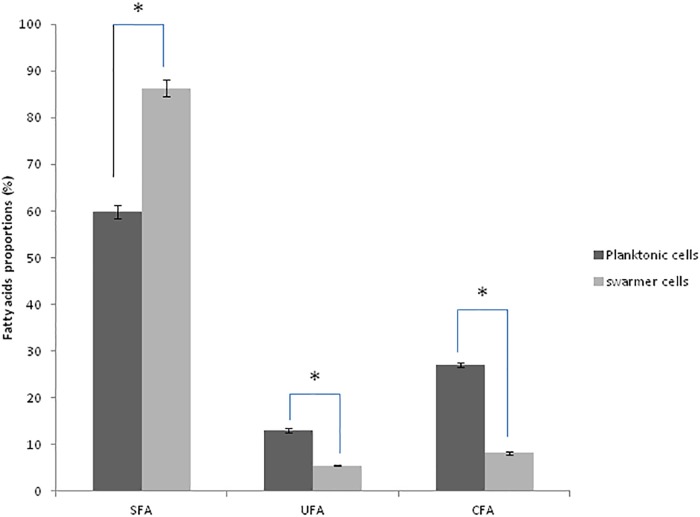
Fatty acid proportions (%) of saturated (SFA), unsaturated (UFA), and cyclic fatty acids (CFA) in planktonic and swarmer cells of Pseudomonas aeruginosa. Different letters mean significant difference (P < 0.05) for each class of fatty acids. (∗) shows significant difference (P < 0.05).